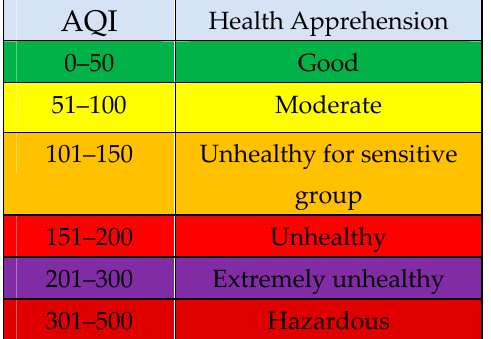
Figure 1. AQI levels according to China and the US Environmental Protection Agency.